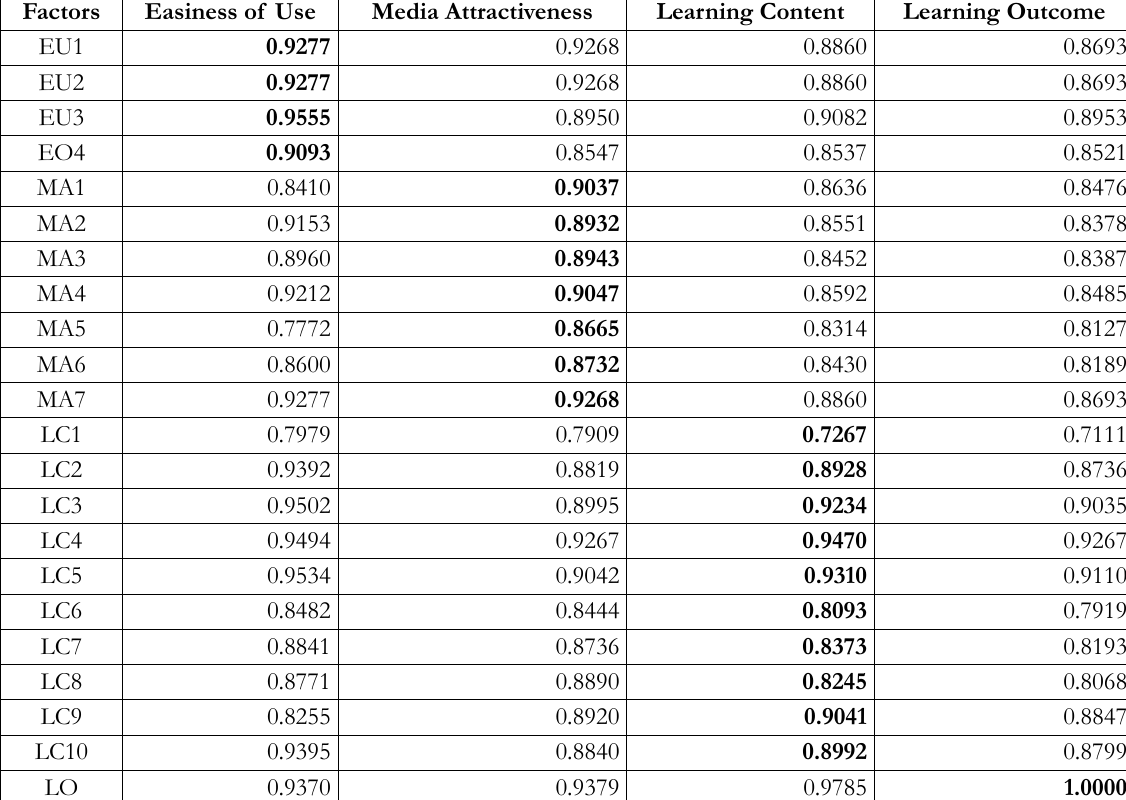
Table 2. Loading Factor of Signal Coding Technique simulation model